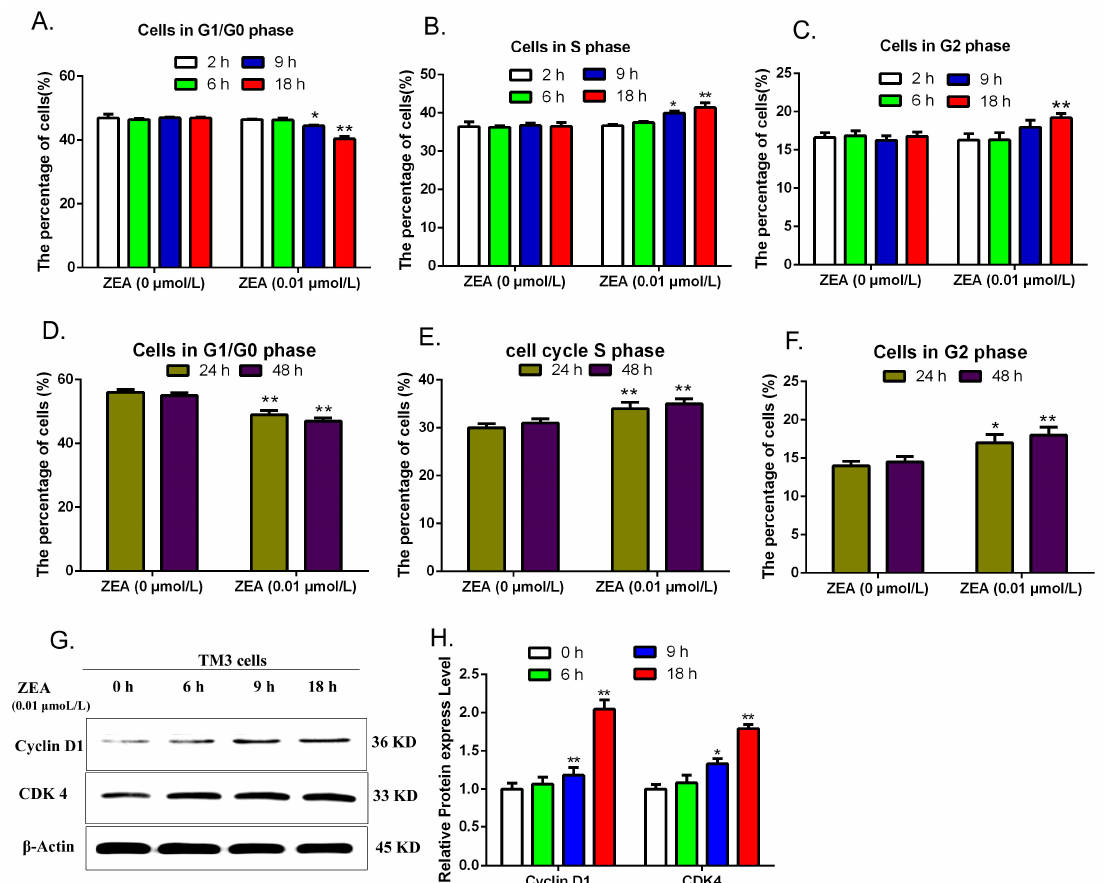
Figure 9. The e ff ects of ZEA on cell cycle in TM3 cells. After treatment with 0.01 µ mol / L ZEA for di ff erent time (0, 2, 6, 9 and 18 h), cells were harvested to detect the cell cycle distribution and to analyze the expressions of the CyclinD1and CDK4 by western blot. ( A , D ) The e ff ects of ZEA on the cell numbers in G1 / G0 phase. ( B , E ) The e ff ects of ZEA on the cell numbers in S phase. ( C , F ) The e ff ect of ZEA on the cell numbers in G2 phase. ( G , H ) The e ff ects of ZEA on the expressions of the CyclinD1, and CDK4. Values represent mean ± S.D. Asterisks suggest a statistically significant di ff erence: * p < 0.05, ** p < 0.01.